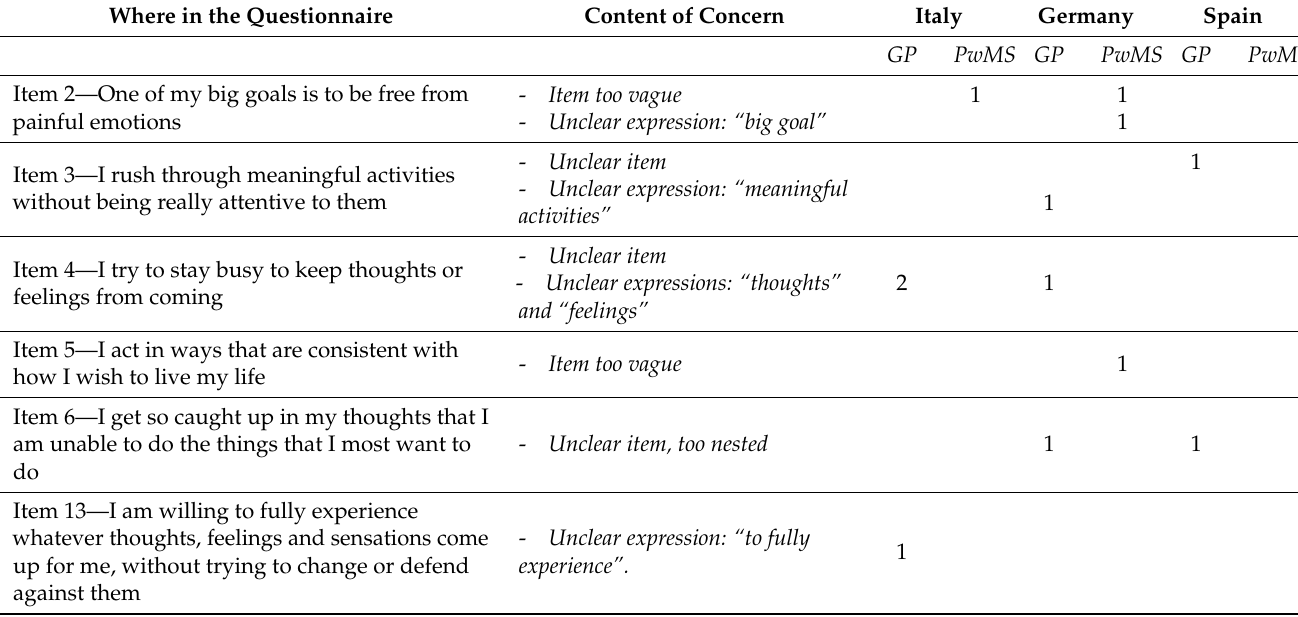
Table 2. Results of the content analysis: concerns about the